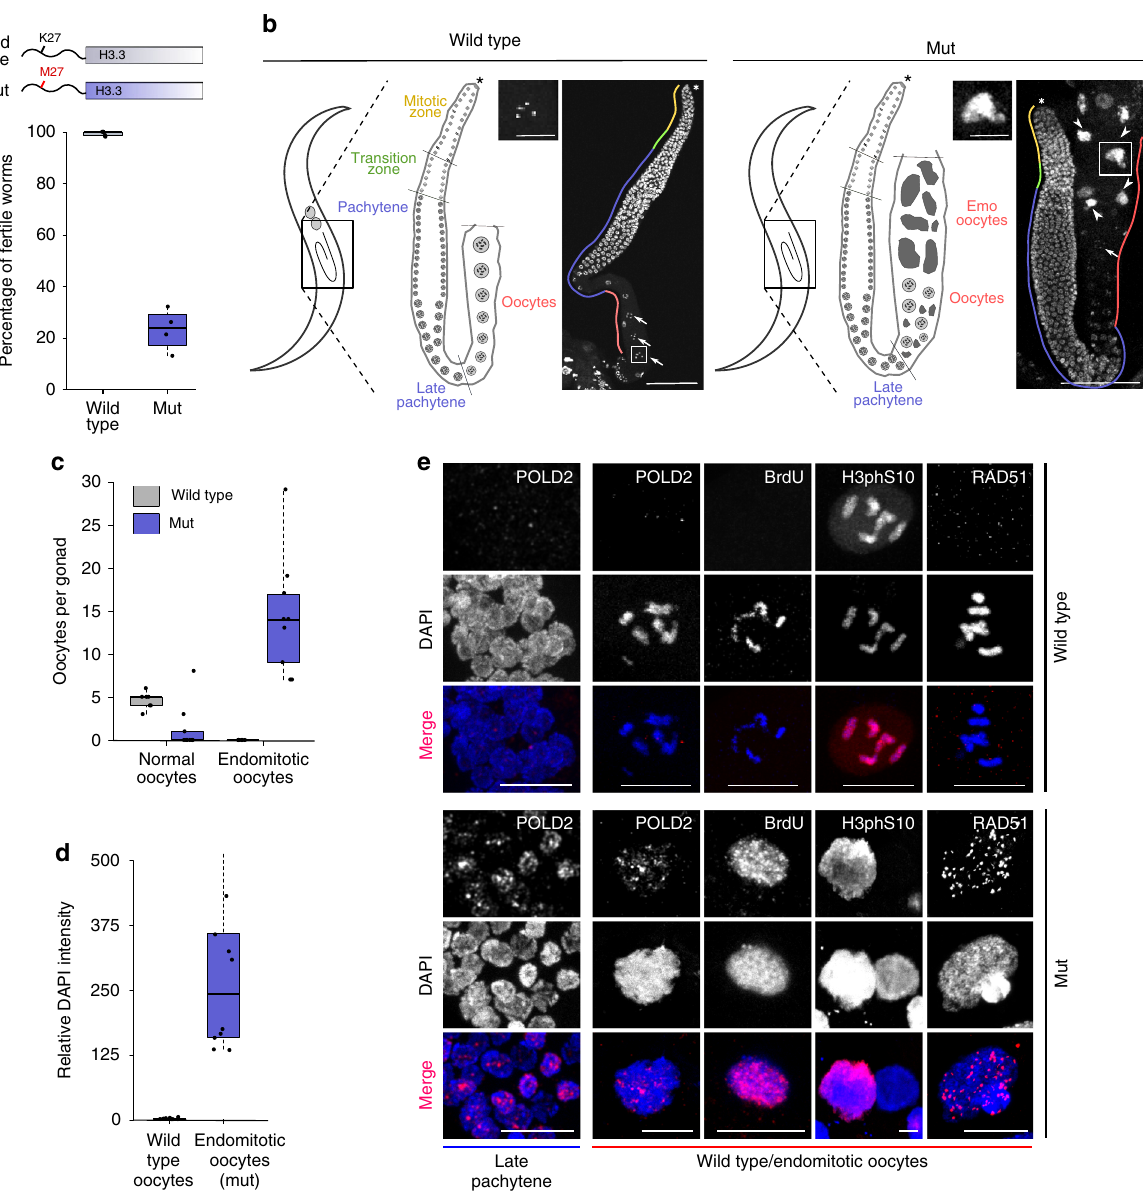
Fig. 1 H3.3K27M mutation drives C. elegans germ cells towards a replicative fate. a Cartoon of H3.3K27M mutation, and boxplot showing fertility levels of wild-type and H3.3K27M mutant (mut) worms at 25 °C. N = 5 for wt, N = 4 for mut. b Cartoon images of worms and germ lines highlighting different stages of germcell development in wild-type and mut worms. DAPI-stained adult gonads of wild-type (left) and mut (right) worms. Distal tip (asterisk), normal (arrows), and endomitotic (arrowheads) oocytes are highlighted. A representative normal (wild type) and endomitotic (mut) oocyte is enlarged. Scale bars represent 75 µ m on whole gonad pictures and 20 µ m on enlarged oocyte pictures. c Boxplot showing the number of normal and endomitotic oocytes per gonad in wild-type and mut worms. N = 7 for wt, N = 9 for mut. d Boxplot showing relative DNA content in endomitotic oocytes compared with wild-type oocytes (diakinesis I, 4 n) based on the DAPI quanti fi cation. N = 10. e H3.3K27M mutant late pachytene and diakinesis germ cells are positive for markers of replication (DNA polymerase delta subunit 2 (POLD2) and BrdU incorporation), mitosis (H3 phosphoS10) and DNA double stranded breaks (RAD-51). POLD2 staining in pachytene nuclei as well as POLD2, BrdU, H3 phosphoS10, and RAD-51 staining in normal oocytes of wild- type and endomitotic oocytes of mut worms are shown. Scale bars equal 15 µ m for late pachytene nuclei images and 10 µ m for wild-type and endomitotic oocytes